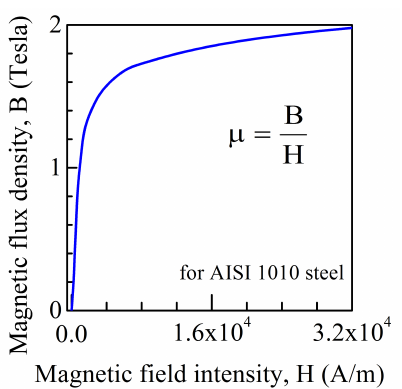
Figure A1. B-H curve used to assign magnetic permeability of 11SMnPb30